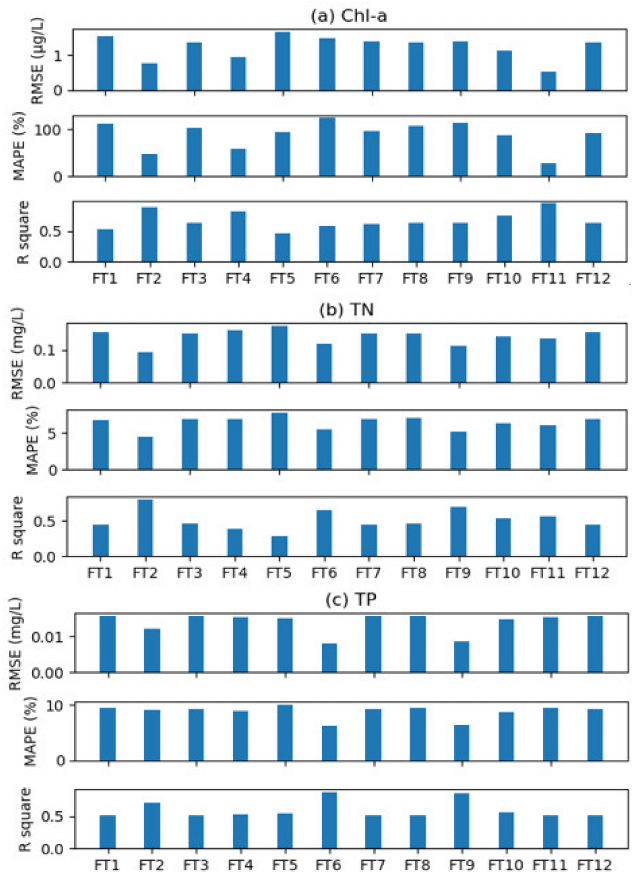
Figure 3. Validation statistics (RMSE, MAPE, and R square) of different spectral characteristics with optimal band combinations in ( a ) Chl-a, ( b ) TN, and ( c ) TP